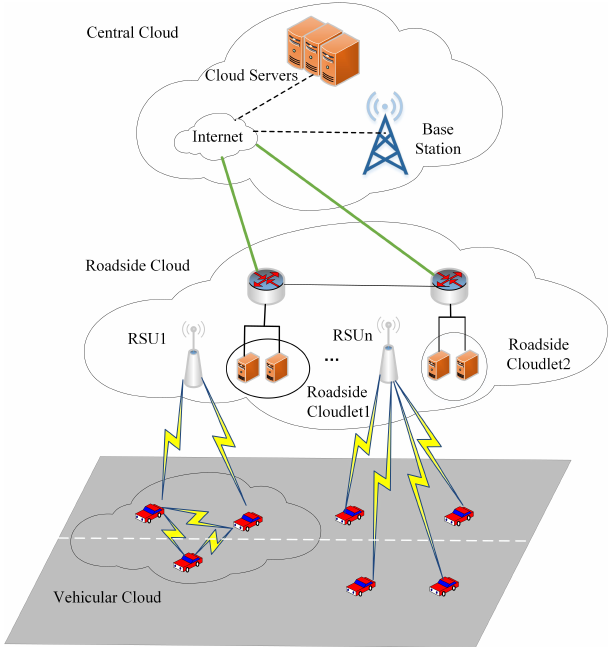
Figure 1. Network access in Vehicular Ad hoc